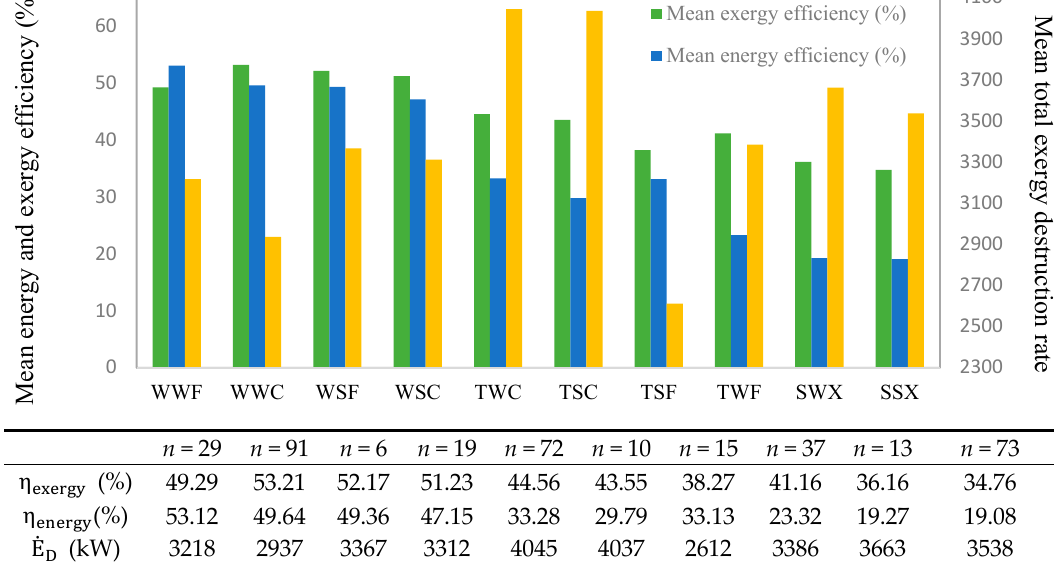
Figure 7. The mean energy and exergy efficiencies as well as the mean total exergy destruction rate of each typical day under optimization condition based on maximum exergy efficiency.